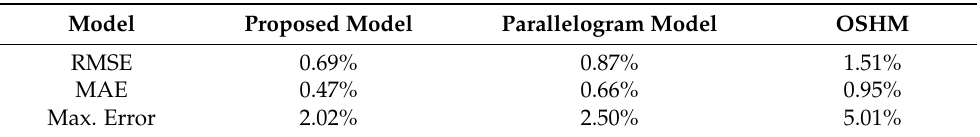
Table 2. Root mean square error (RMSE), mean absolute error (MAE), and max. error of SOC Estimation with different hysteresis models.